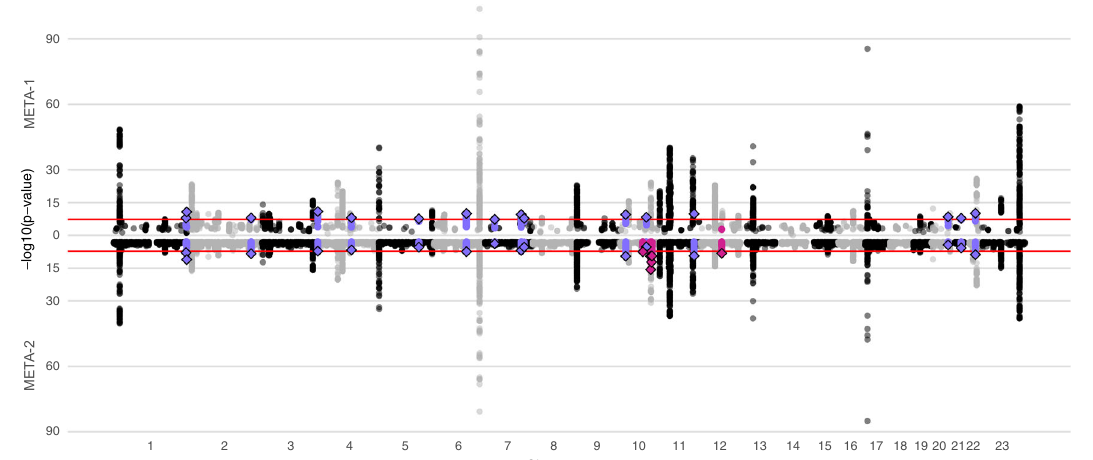
Fig. 1 | Study setting. The fl ow diagram illustrates the data usage and analytical steps of our study. We conducted a GWAS of uterine leiomyomata (UL) in 18,060 cases and 150,519 female controls from the FinnGen project. Subsequently, we meta-analysed the FinnGen-based results with summary statistics from a previous UL meta-GWAS 12 . META-1 included 53,534 cases and 373,024 female controls and was restricted to the top 10,000 variants from the previous study 12 . META-2 was conducted genome-widely in 38,466 cases and 329,437female controls, excluding 23andMe data due to the data usage policy. Downstream analyses assessing